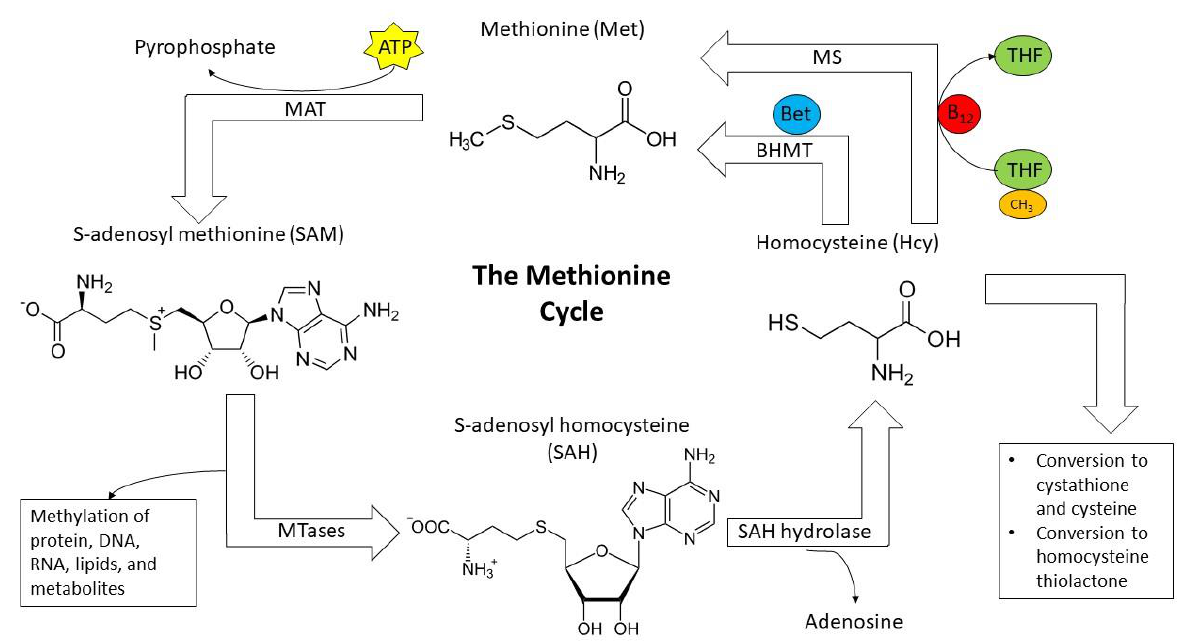
Figure 2. The methionine cycle. Methionine is converted to SAM by methionine adenosyltransferase (MAT) and subsequently used as a methyl donor in methyltransferase reactions. This yields SAH as a byproduct, hydrolyzed to homocysteine. Homocysteine is removed from the cycle by conversion to homocysteine thiolactone or through the trans-sulfuration pathway to cysteine. Alternatively, it is remethylated by one of two pathways: using methionine synthase with B12 as a cofactor and 5-methyltetrahydrofolate as a methyl donor or using betaine homocysteine methyltransferase and betaine as a methyl donor.